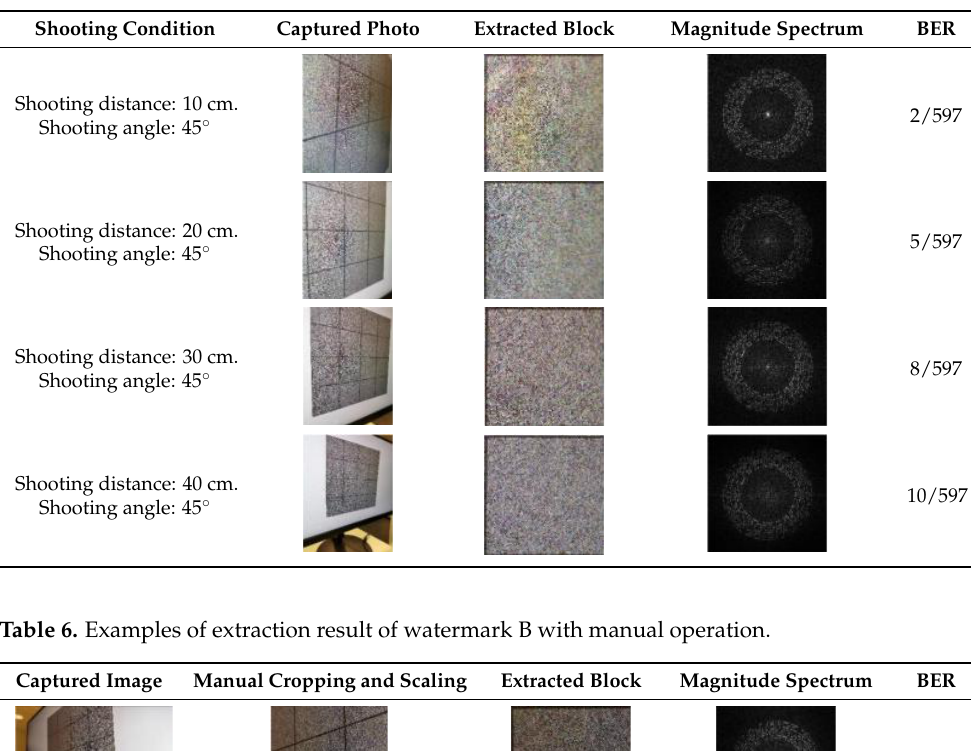
Table 5. Examples of automatically extraction result of watermark B.